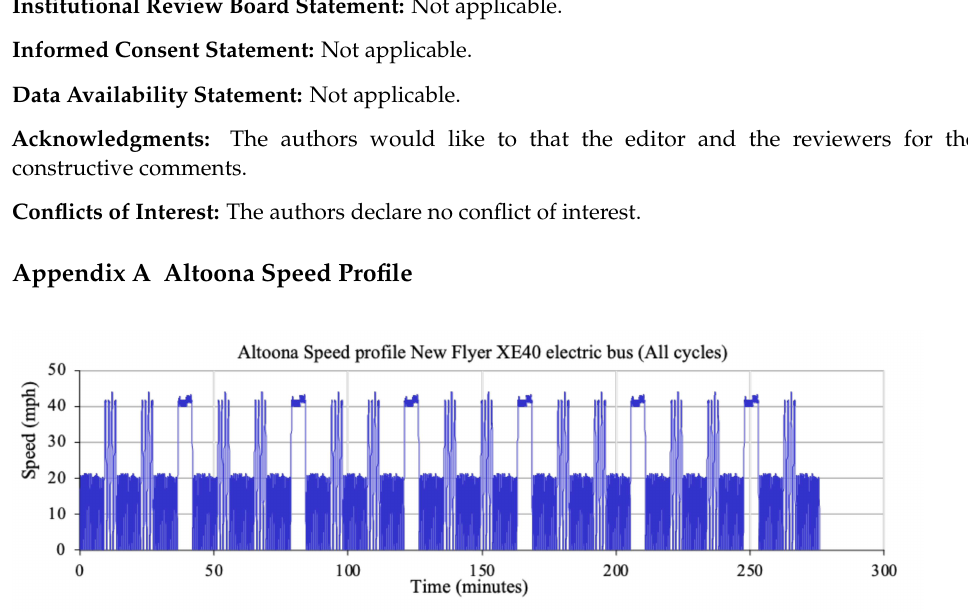
Figure A1. Altoona’s combined speed profiles.